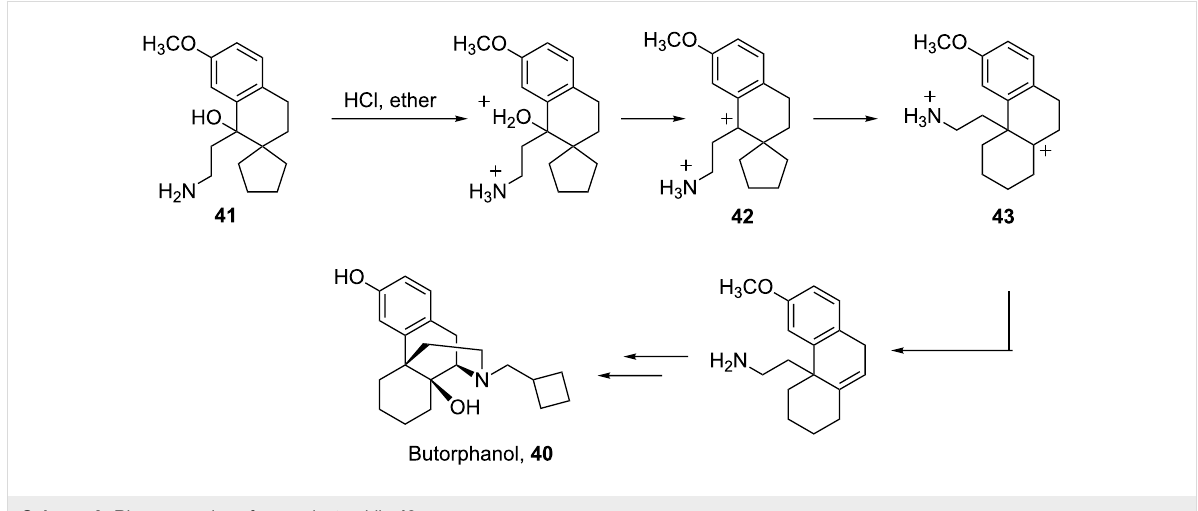
Scheme 9: Ring expansion of superelectrophile 42